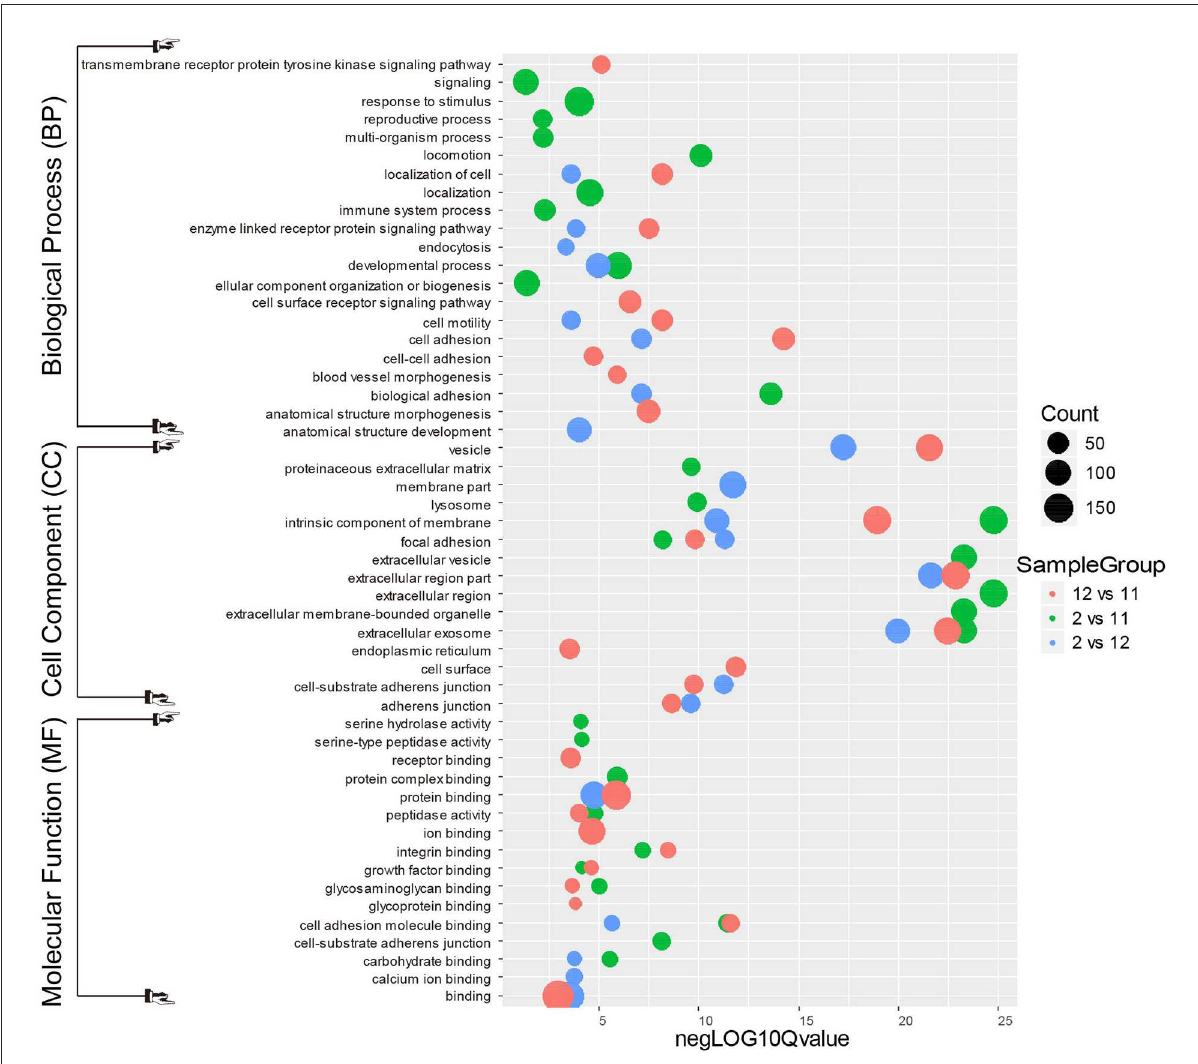
FIGURE5 Gene Ontology analysis for differentially expressed mink testicular N-glycoproteins at different stages of spermatogenesis. All differentially expressed N-glycoproteins were clustered into the biological process (BP), cellular component (CC) and molecular function (MF) GO categories based on GO slim terms. Terms that were significantly enriched for N-glycoproteins (adjusted P < 0.05) are shown.